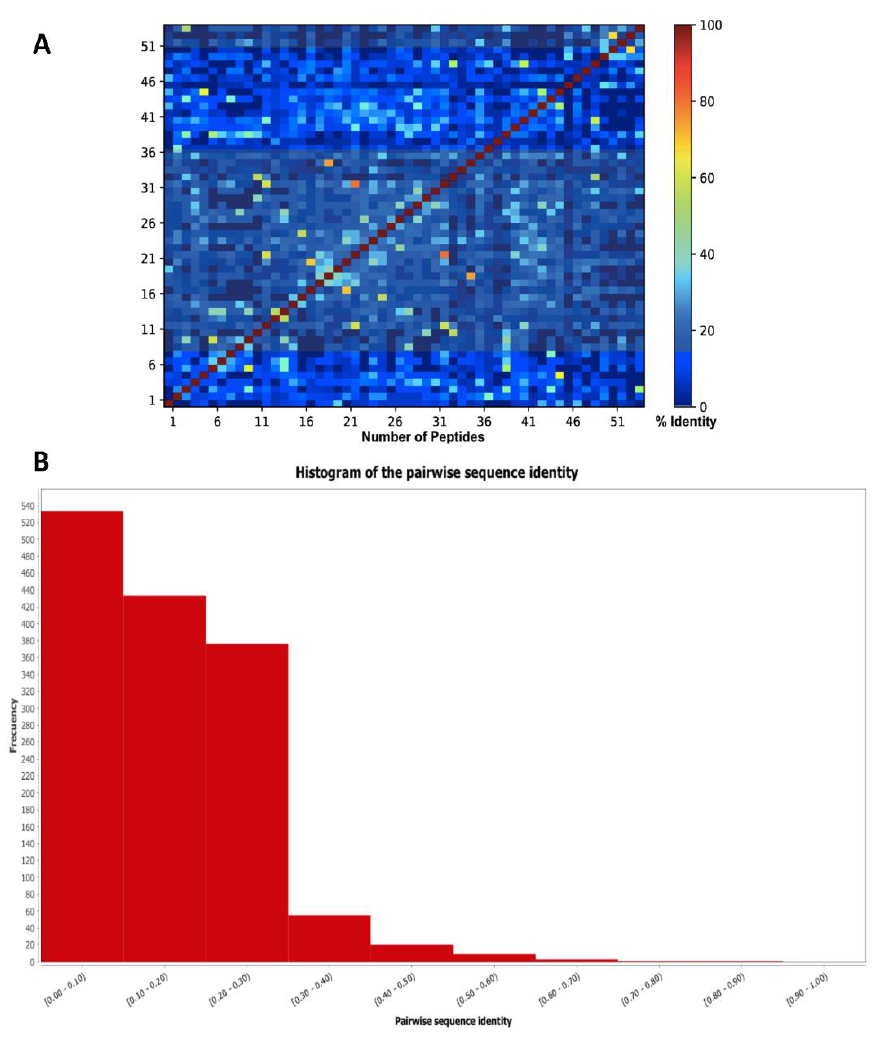
Figure 10. ( A ) Heat map and ( B ) histogram of pairwise sequence identity of SET 1 (54 lead com-